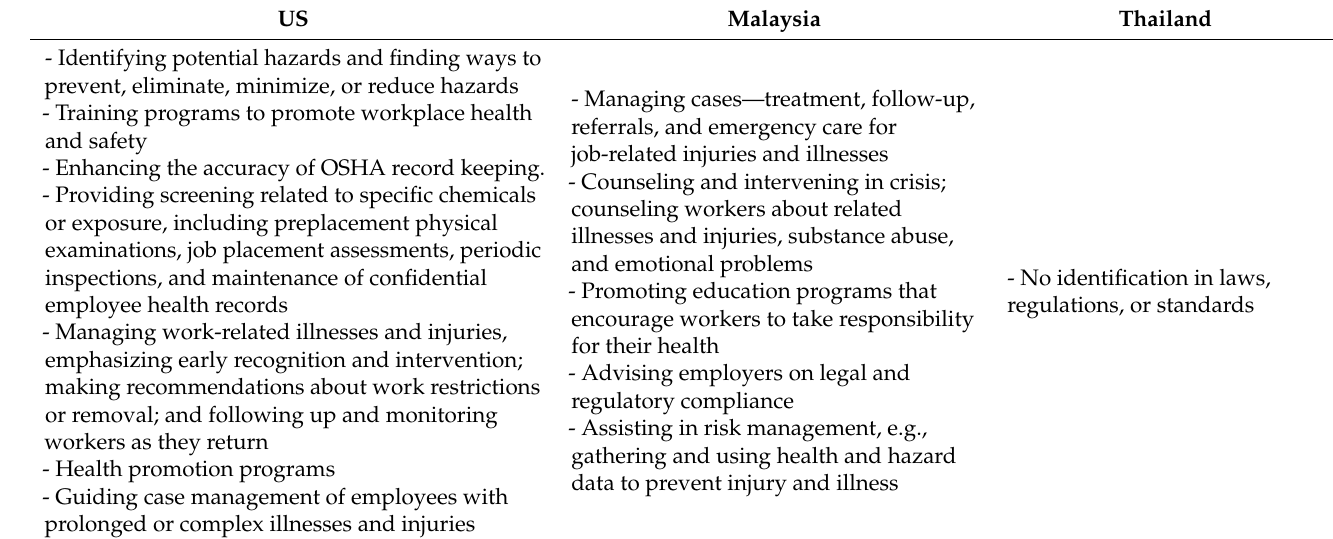
Table 3. Duties of occupational health